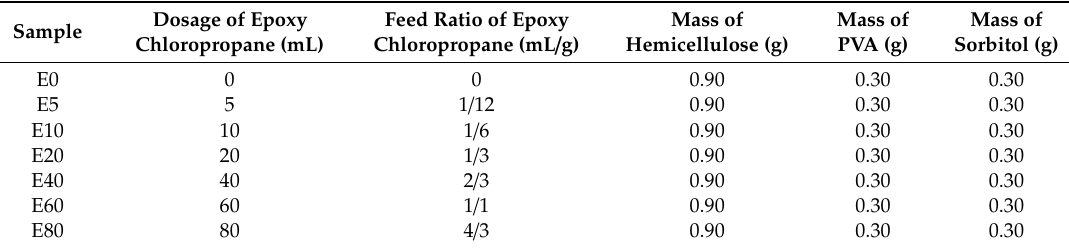
Table 1. Designation of etherified hemicellulose